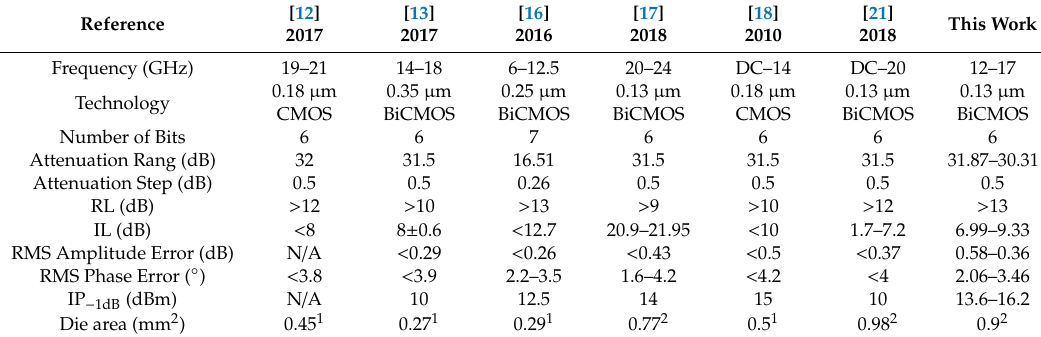
Table 3. Performance comparison of relevant digital control step attenuators.